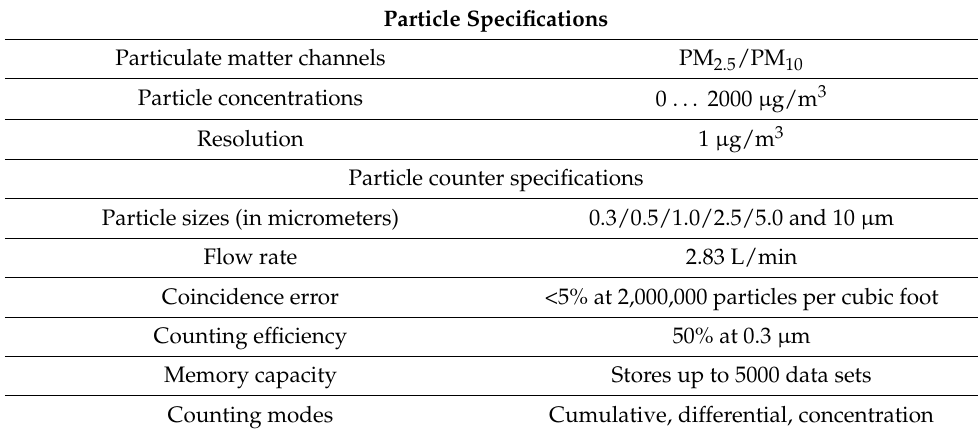
Table 2. Technical parameters of measuring instrument